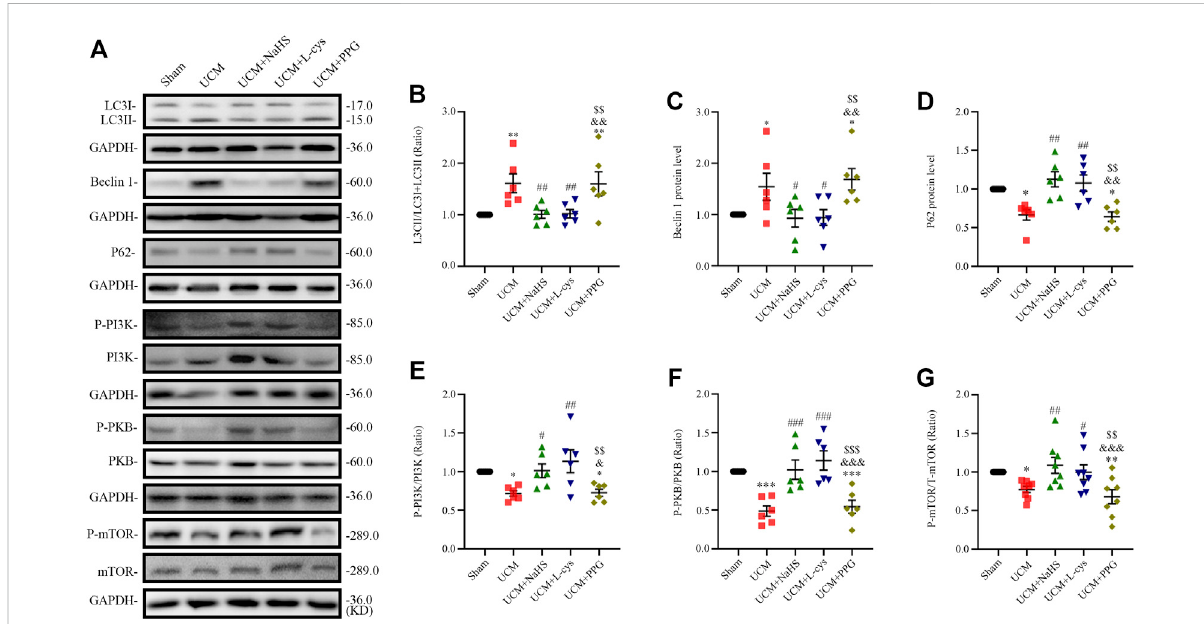
FIGURE 4 NaHSandL-cystreatmentinhibitPI3K-PKB-mTOR-activatedautophagyinUCMmice. (A) RepresentativeWesternblotimagesofLC3,becline- 1,P62, p-PI3K/PI3K,p-PKB/PKBand p-mTOR/mTORinthehearttissue ofthe fi vegroupsofmice. (B – D) Quanti fi cation oftheLC3II/LC3 (I+ II)ratio, becline-1proteinlevels,andp62proteinlevelsinthehearttissueofthe fi vegroupsofmice,with n =6pergroup. (E – G) Quanti fi cationofthep-PI3K/ PI3K ( n = 6 per group), p-PKB/PKB ( n = 6 per group) and P-mTOR/mTOR ( n = 8 per group) levels in the heart tissue of the fi ve groups of mice. Data are represented as Mean ± SEM. * p < 0.05, ** p < 0.01, *** p < 0.01 vs. Sham group; # p < 0.05, ## p < 0.01, ### p < 0.001 vs. UCM group; & p <